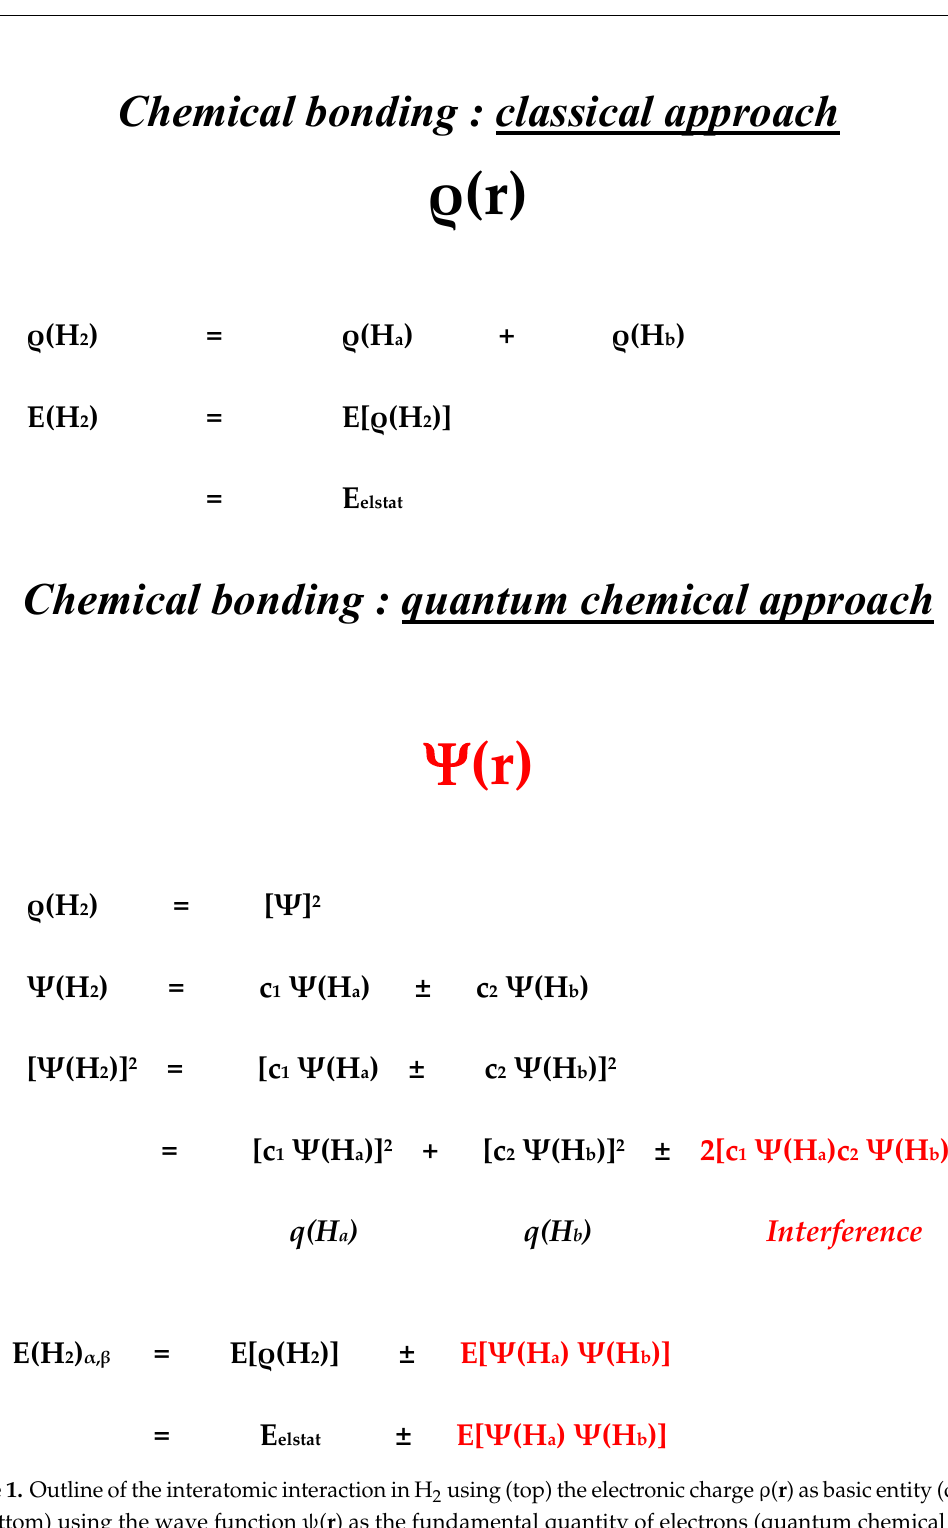
Scheme 1. Outline of the interatomic interaction in H 2 using (top) the electronic charge ρ ( r ) as basic entity (classical ap- proach) and (bottom) using the wave function ψ ( r ) as the fundamental quantity of electrons (quantum chemical approach).